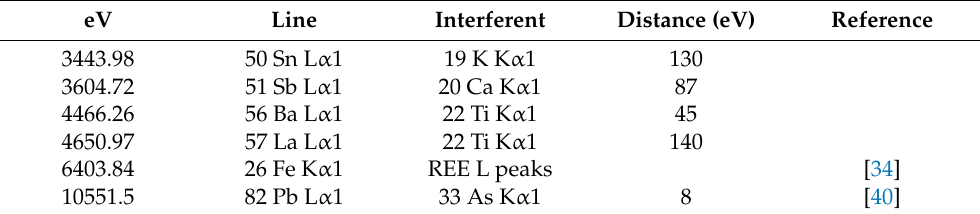
Table 5. Potential K/L, K/M and L/M interferences (keV) [34].